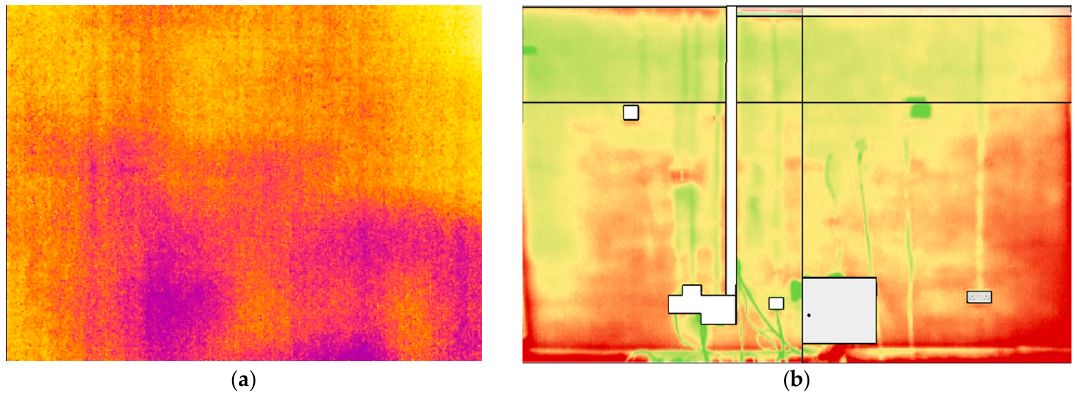
Figure 5. ( a ) Low-resolution thermal image; ( b ) high-resolution thermal image (custom palette).